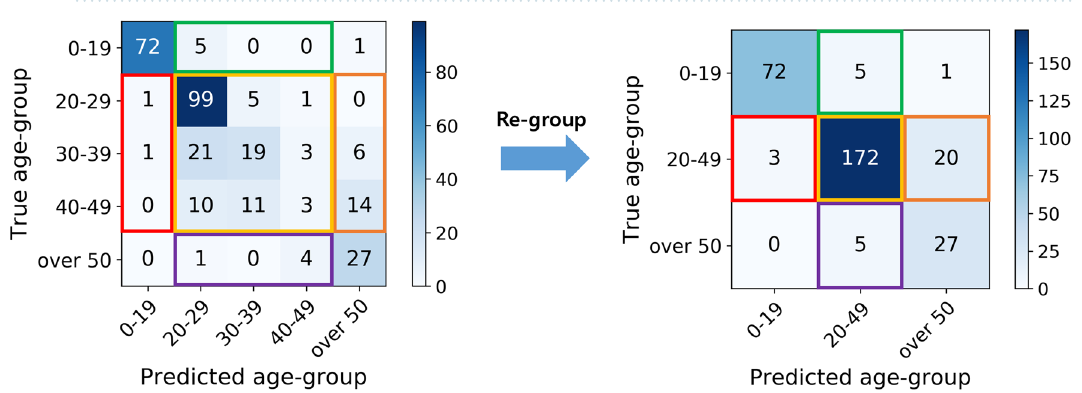
Figure 3. Conversion of the age-group prediction result of the five age-groups to the three